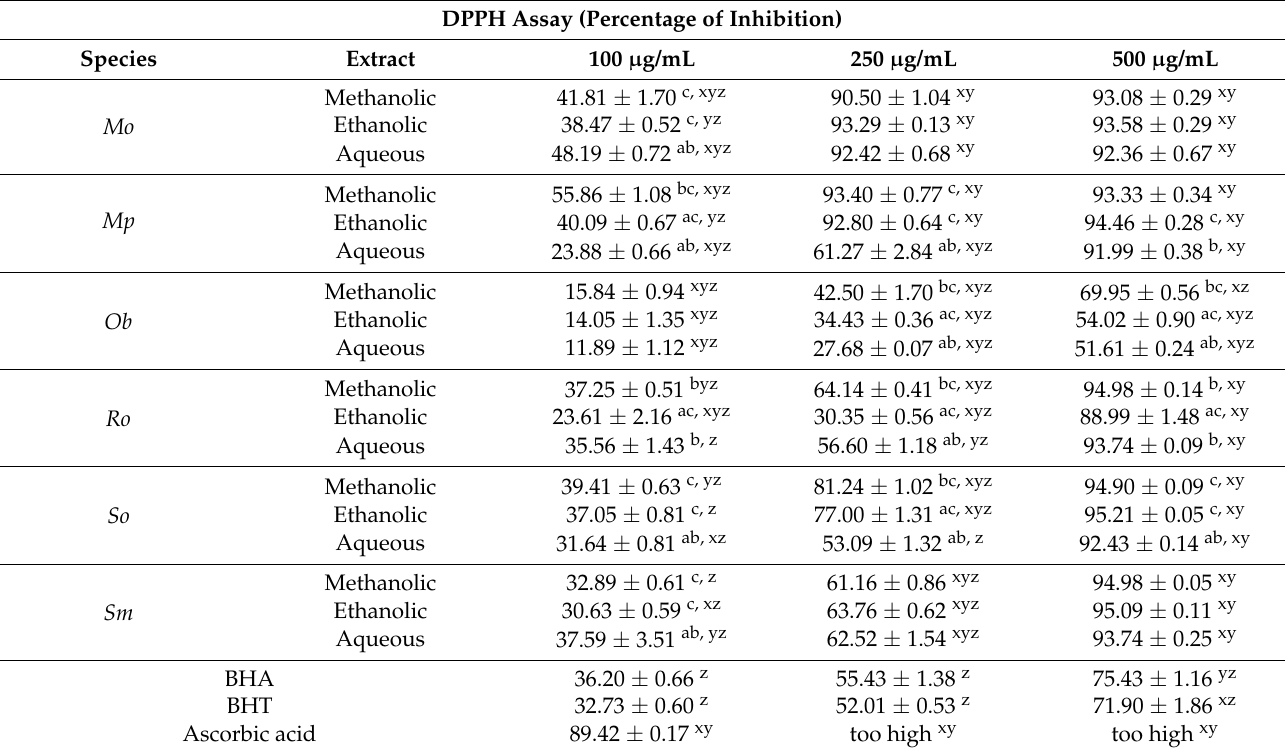
Table 4. The activity of the selected plant extracts and standards (positive controls) against DPPH radical, presented as means of percentage of inhibition ± standard